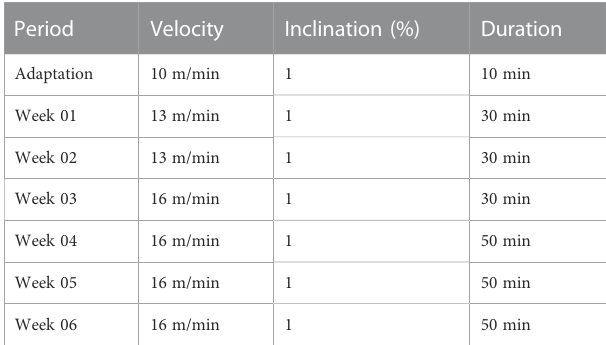
TABLE 1 Moderate exercise protocol on treadmill.